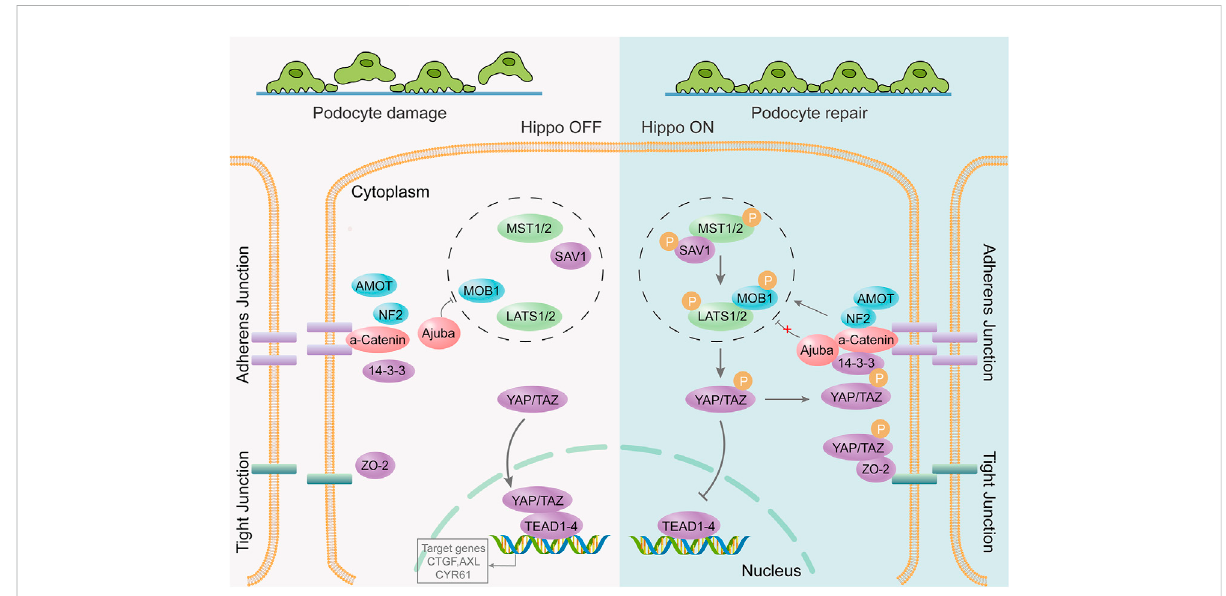
FIGURE 3 The Hippo signalingpathwayis involved in repairafter podocyte damage. The podocytejunction is destroyed, thefoot process disappears, and theHipposignaling pathwayisactivated.YAP/TAZphosphorylationoccursthroughaseriesofcascadingphosphorylationreactions.Phosphorylated YAP/TAZ cannot be nucleated to bind to transcription factors; however, it remains within the cytoplasm to function or undergo degradation. It protects podocytes from further damage, thereby promoting post-injury